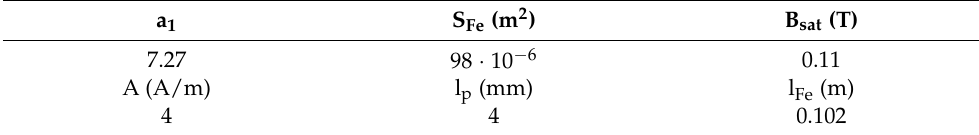
Table 2. Values of the magnetic parameters of the coupled inductor.